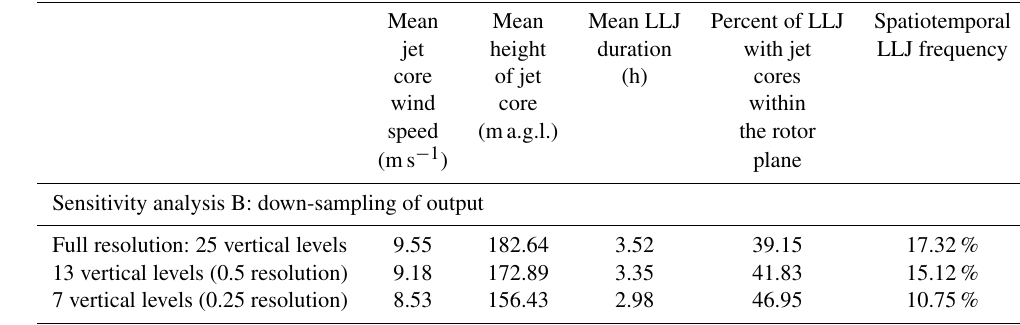
Table 5. Spatially and temporally averaged LLJ properties as a function of model output vertical resolution. Mean Mean Mean LLJ Percent of LLJ Spatiotemporal jet height duration with jet LLJ frequency core of jet (h) cores wind core within speed (ma.g.l.) the rotor (ms − 1 )